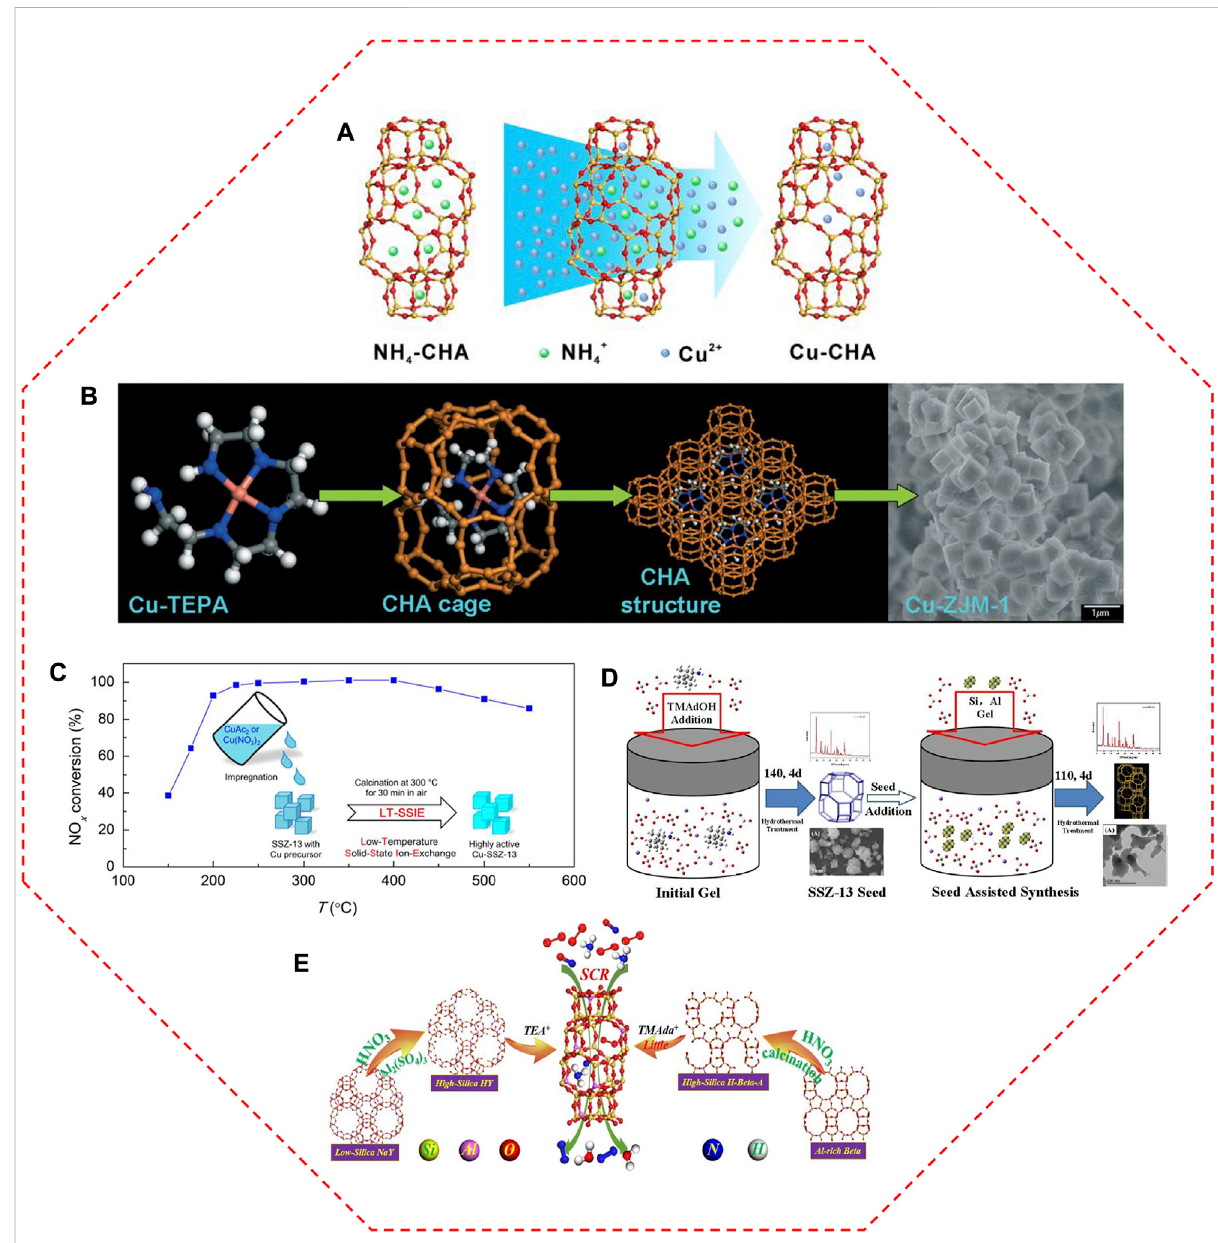
FIGURE 3 The representative synthesis methods for Cu-SSZ-13 catalysts. (A) Schematic diagram of aqueous ion exchange method. Reproduced with permissionXinetal.(2018),Copyright2018,JohnWileyandSons. (B) Mechanismofone-potsynthesismethodwithCu-TEPAtemplate.Reproduced withpermissionRenetal.(2011),Copyright2011,RoyalSocietyofChemistry. (C) Diagramoflow-temperaturesolid-stateion-exchangemethodand corresponding NO x conversion of the obtained Cu-SSZ-13 catalyst. Reproduced with permission Ma et al. (2019), Copyright 2019, American Chemical Society. (D) Synthetic process of seed-oriented synthesis method. Reproduced with permission Zhang X. Y. et al. (2019), Copyright 2019, Elsevier Publishers. (E) The inter-zeolite conversion route with low-cost NaY and Al-rich beta precursors and alternately low cost or low content structure directing agents. Reproduced with permission Zhang et al. (2021), Copyright 2021, Elsevier